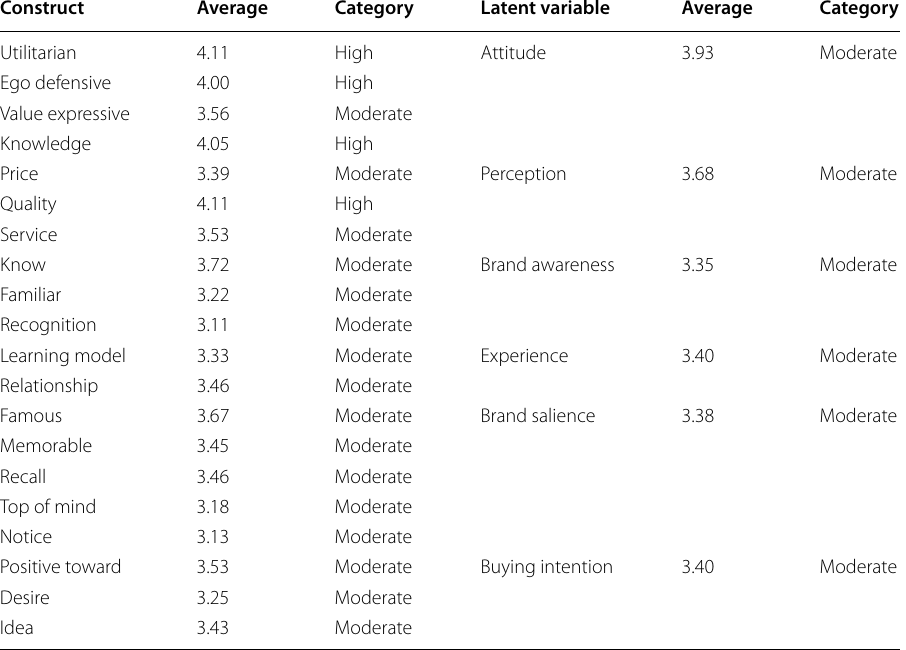
Source: analysis of primary